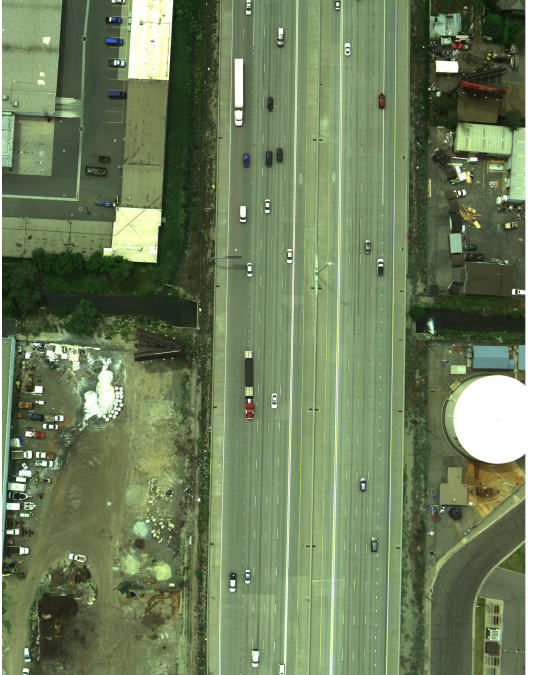
Figure 3. A sample section of a geo-referenced color image of the